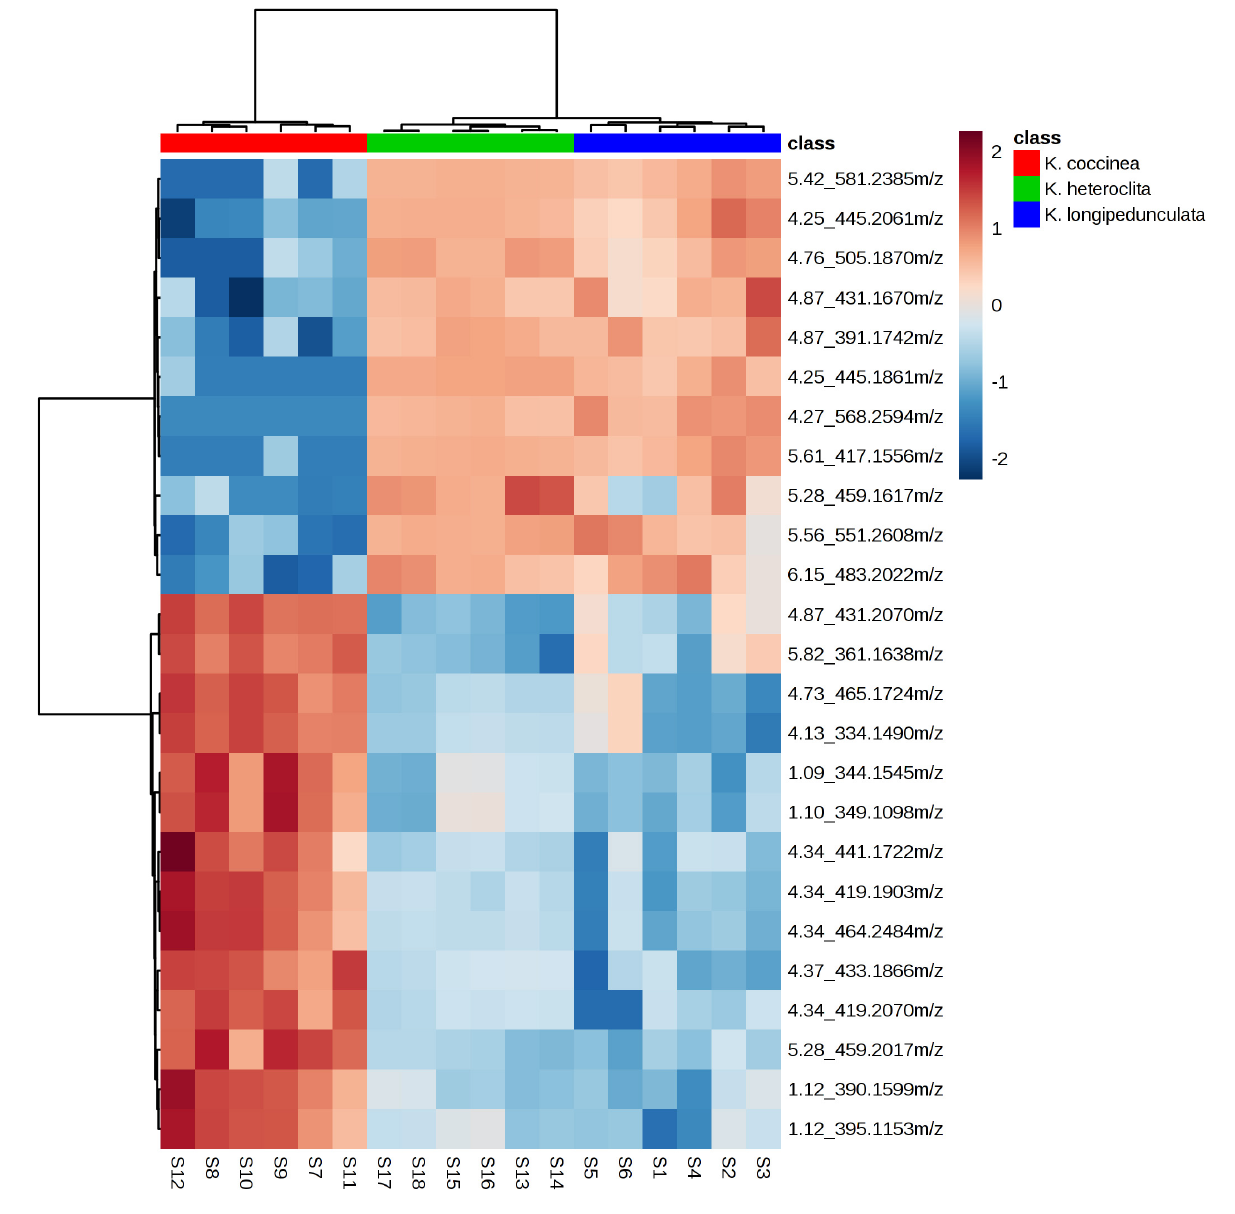
FIGURE 3 | The heatmap presenting the distribution of constituents in K . longipedunculata , K. coccinea and K.